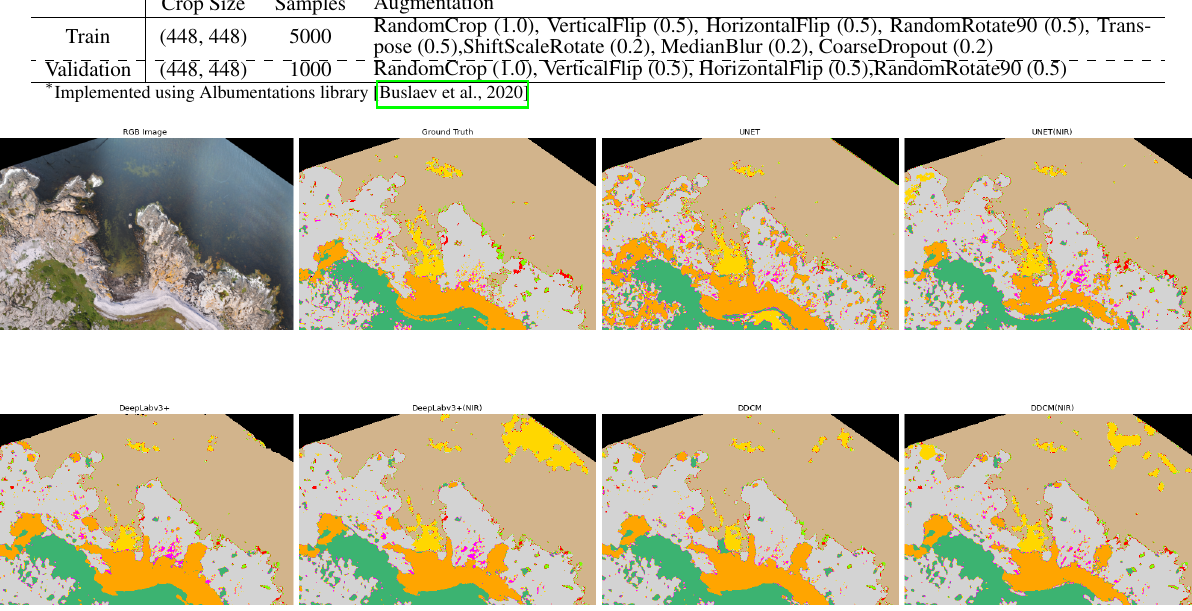
Figure 3. Example of predictions on a test image. Table 3. Overall evaluation scores of RGB-only models. The best scores per column is highlighted in blue Model